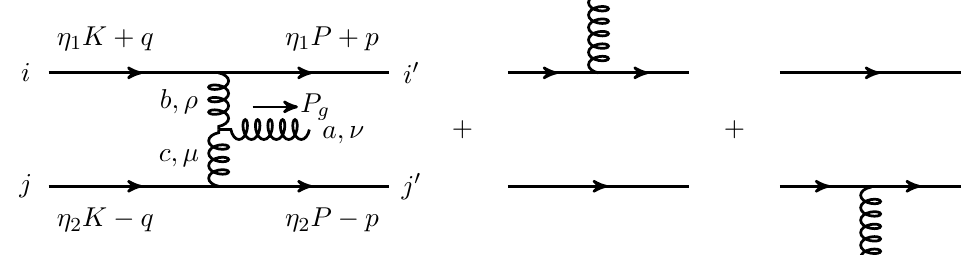
Figure 1. Radiative capture into bound